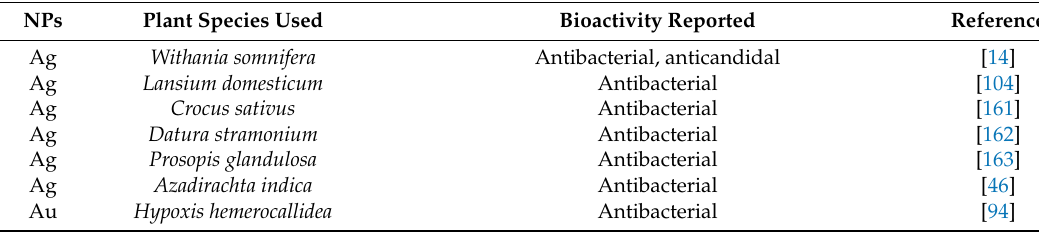
Table 2. Bioactivities of green-synthesized